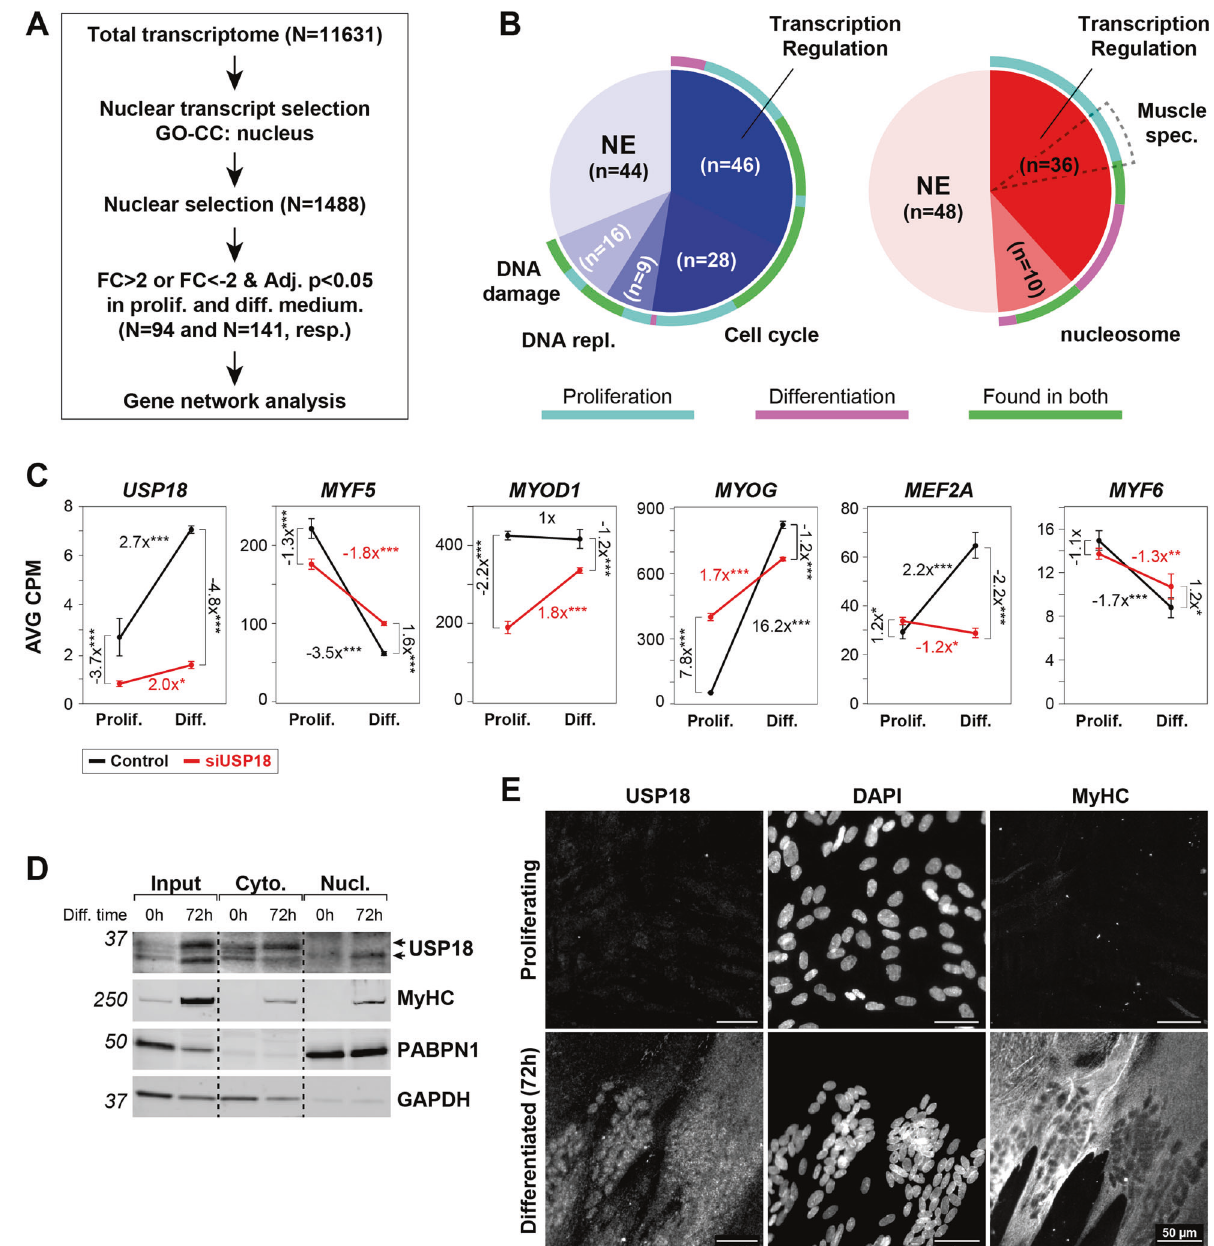
Fig. 6 Truncated USP18 isoform is nuclear in differentiated cultures, and depletion of USP18 leads to re-programming of myogenic regulatory factors. A Representative western blot shows cellular localization of USP18, MyHC, PABPN1 and GAPDH in proliferating and 72 h differentiated immortalized cell cultures. B Representative immuno fl uorescence images show USP18 staining in proliferating and 72 h differentiated immortalized cell cultures. MyHC depicts differentiated cells. Scale bar is 50 μ m. C A schematic overview of the nuclear transcript selection. D Pie charts show signi fi cantly enriched UP-keywords in USP18 depleted cultures cultivated for 24 h. In the left blue pie chart are UP-keywords of genes that are signi fi cantly decreased (FC < − 2, Adj. p value < 0.05) and in the right red pie chart increased genes (FC > 2, Adj. p value < 0.05). The ring around the pies indicate whether the signi fi cantly affected genes were found in proliferating (cyan), differentiation (pink) or in both medium conditions (green). Dashed pie depicts the muscle speci fi c genes within the ‘ transcription regulation ’ UP-keywords. E Dot plots show the average CPM for fi ve myogenic regulatory genes in control (black) and USP18 KD (red) cells cultured in proliferation or differentiation medium. Average and error bars (SD) are from N = 3. Statistical signi fi cance is depicted by asterisks. (*0.05 – 0.005, **0.005 – 0.0005, ***< In vitro muscle maturation is disrupted in USP18 depleted 117 signi fi cantly affected proteins showed that the muscle proteins, cells DNA replication, and the mitochondria were the most affected Since the sarcomere network and calcium channels were amongst networks (Fig. 7E). For the 63 affected proteins, we compared fold the affected networks in USP18 KD, we assessed whether the function changes between RNA and protein and found a higher change on of both networks is impacted. A calcium fl ux was measured in protein levels (Fig. 7F). This suggests that protein stability might also multinucleated cells. In control cultures, multinucleated cells showed affected by USP18.